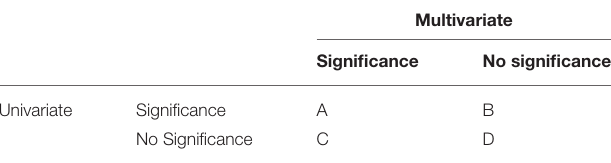
TABLE 2 | Comparison table of